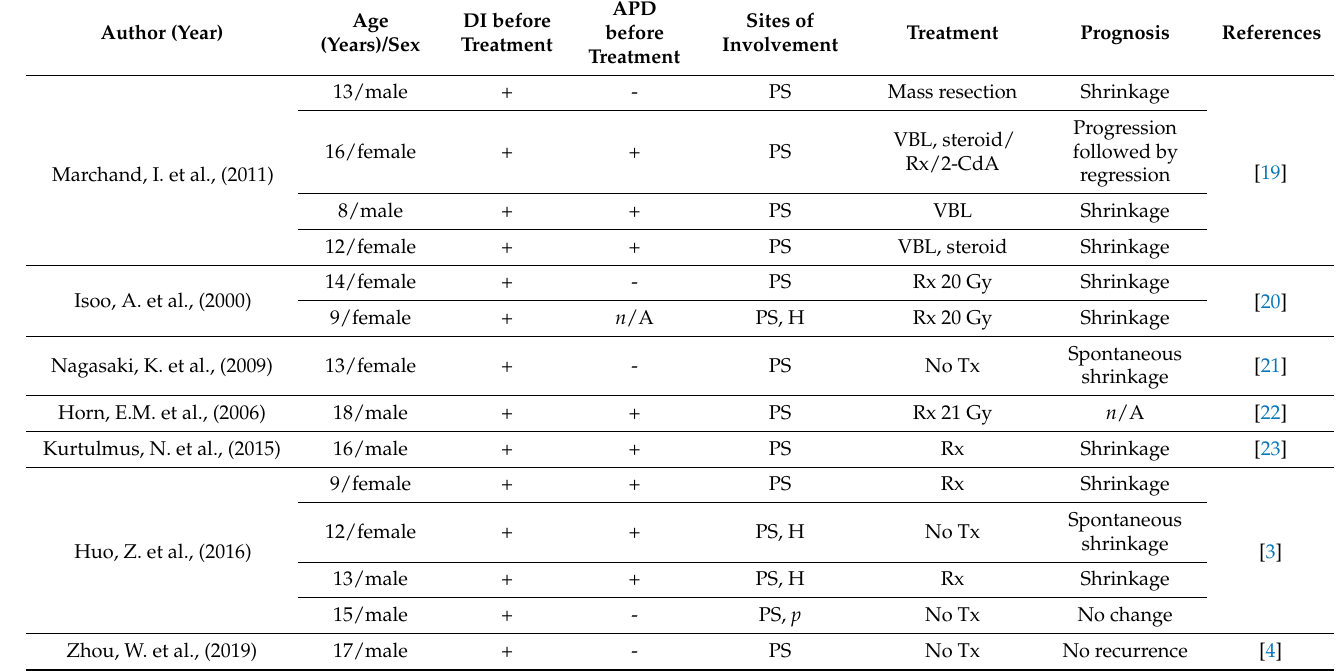
Table 2. Summary of isolated suprasellar lesion LCH patients with CDI in children and adolescents after